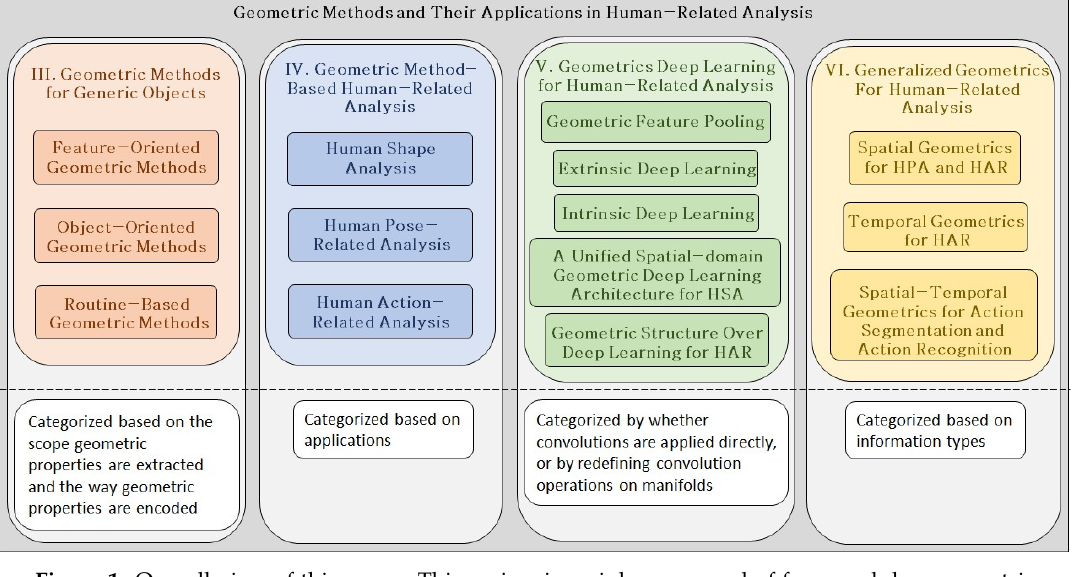
Figure 1. Overall view of this paper. This review is mainly composed of four modules: geometric methods for generic objects; geometric method-based human-related analysis; geometric deep learning for human-related analysis; and generalized geometrics for human-related analysis. Each module has its subsections, each of which is a class of methods based on its categorization standards. HSA, human shape